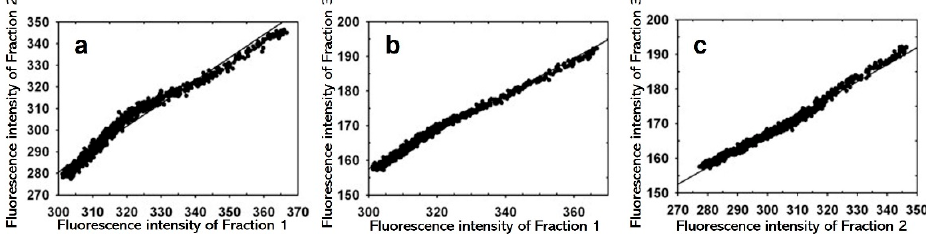
Figure 4. Scattering plots of fluorescence decay among the three fractions . Scattering plots of fluorescence decay of ( a ) Fraction 1 versus Fraction 2; ( b ) Fraction 1 versus Fraction 3; ( c ) Fraction 2 versus Fraction 3. Table 1. Correlation analysis of fluorescence decay of phycobiliproteins with each different aggregate. Fraction Pearson Correlation Coefficient